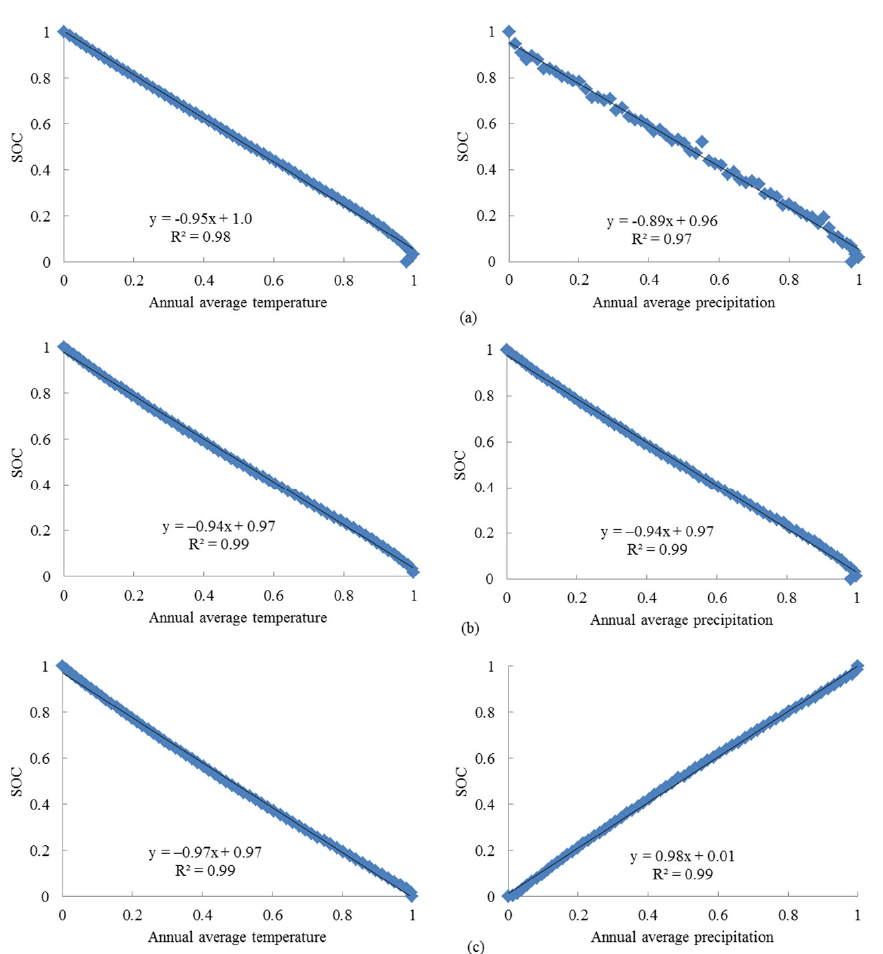
Figure 6. Relative relationships between temperature, precipitation, and SOC for the three wheat cropping systems. ( a ) The northern wheat cropping area, ( b ) the southern wheat cropping area, ( c ) the western wheat cropping area.